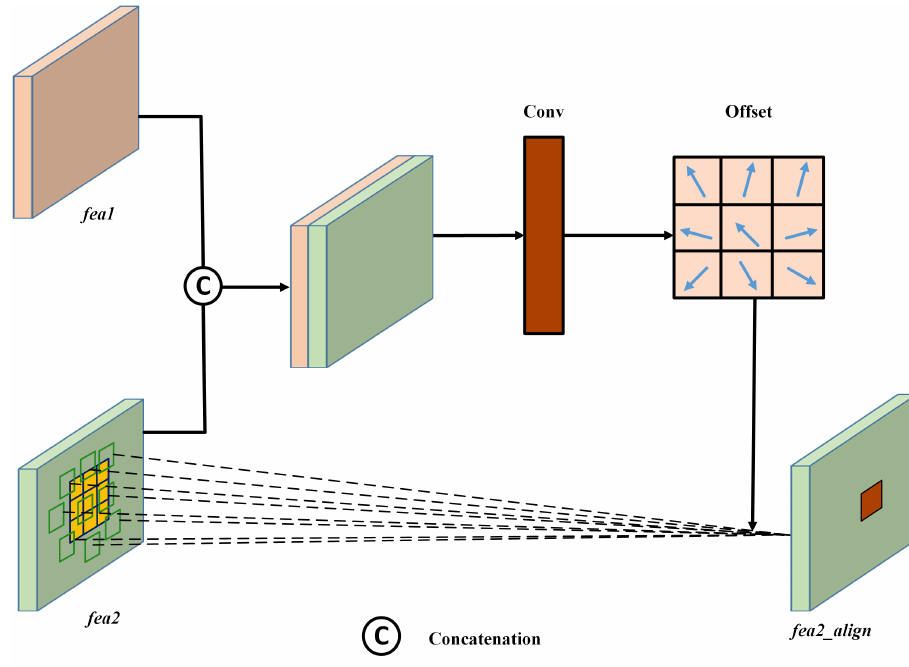
Figure 6. Architecture of the deformable convolution unit (DCU).